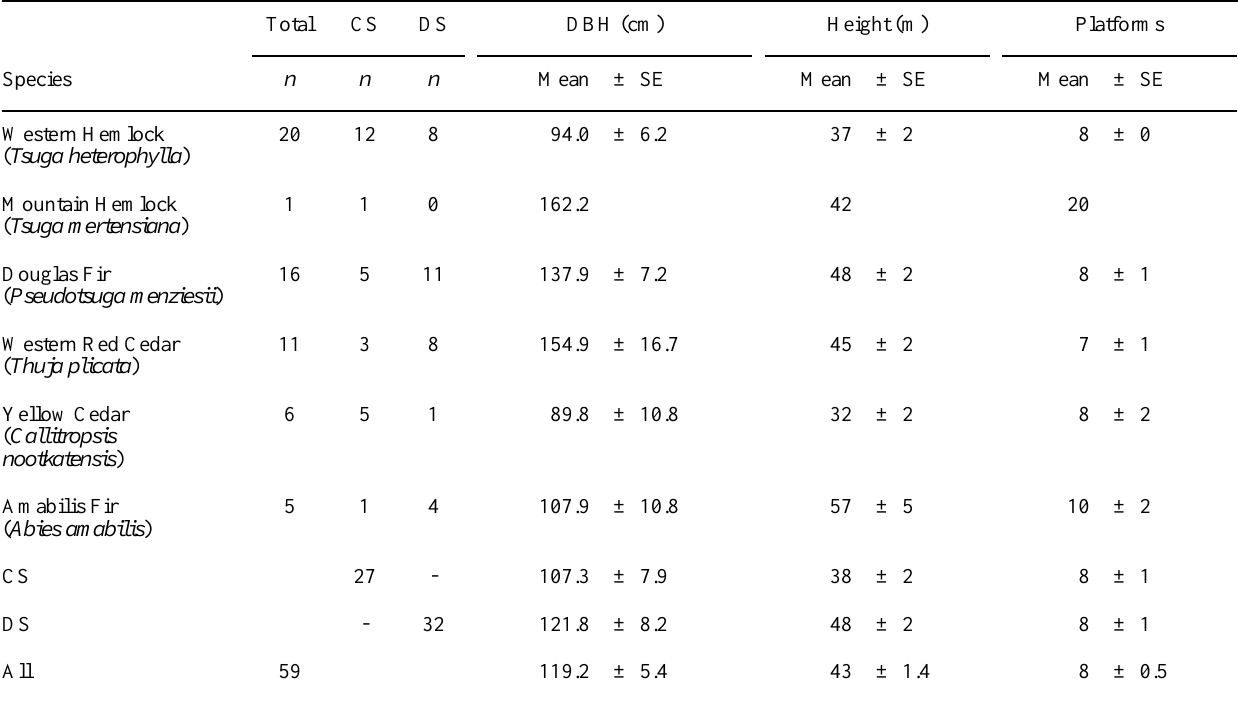
Table 1. Nest tree characteristics by dimension and tree species. Nests were found in a variety of tree species, with most in western hemlock and douglas-fir. Nest trees had, on average, eight potential nesting platforms, and were shorter at Clayoquot Sound (CS) compared with Desolation Sound (DS). Total CS DS DBH (cm) Height (m) Platforms Mean ± SE Mean ±